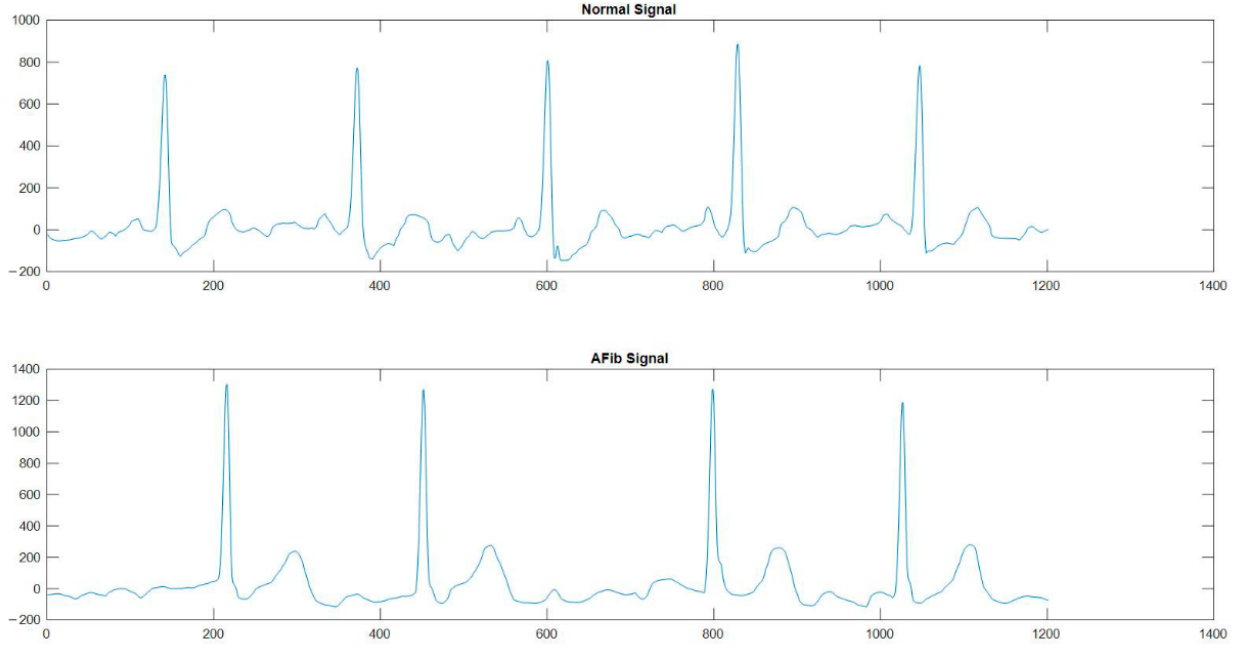
Figure 6. An example of ECG signals without heart defects (Normal Signal) and signals with atrial fibrillation (AFib signal) from the CinC Challenge database [31].